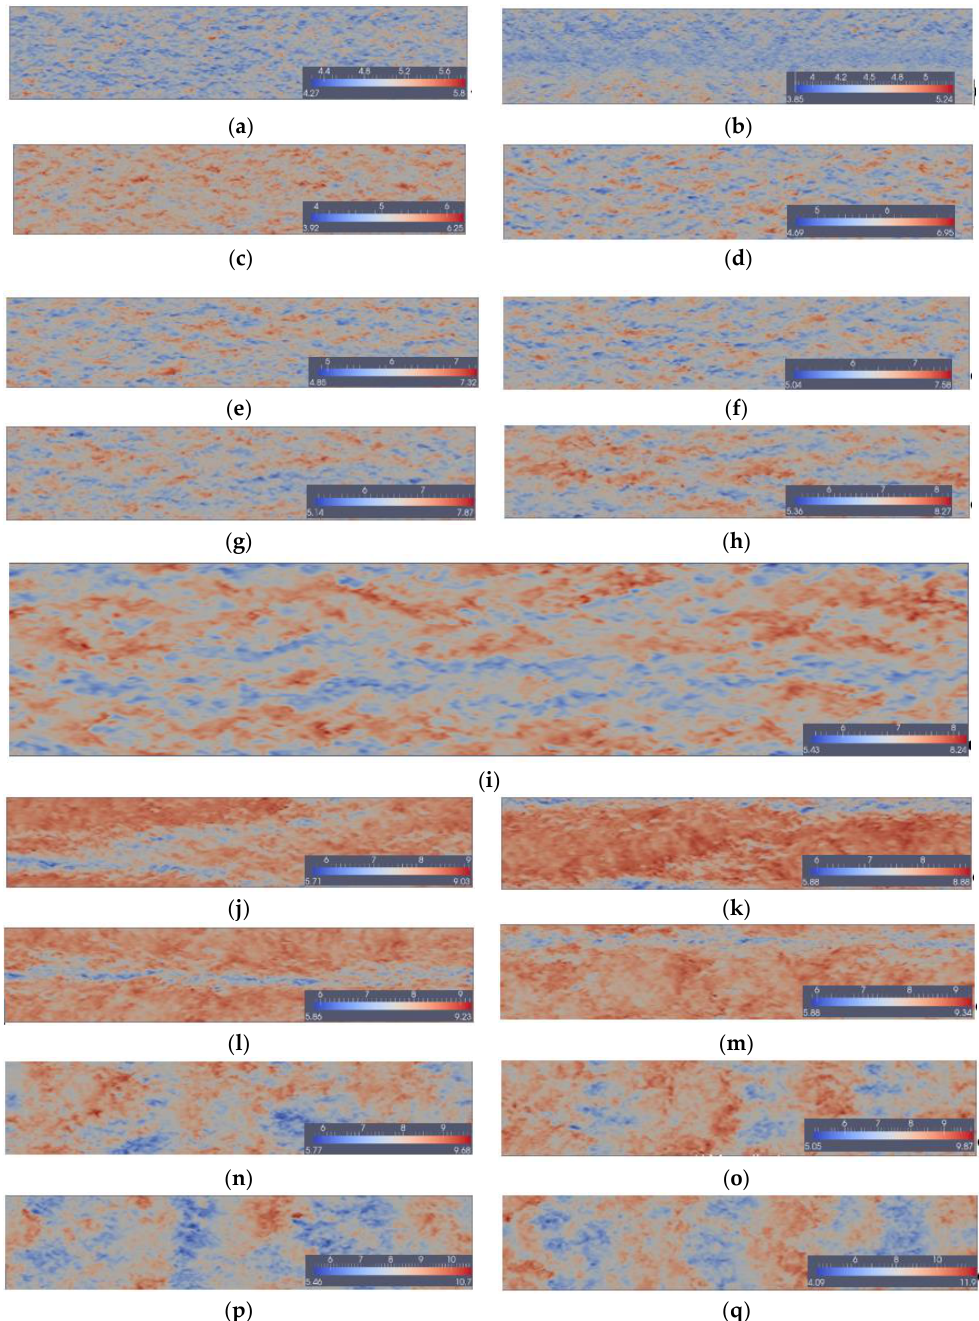
Figure 3. Streamwise velocity in the xy plane (whole domain) at a height of 0.2 for each case. ( a ) to ( q ) represent cases 1 to 17, respectively, going from very stable, to neutral and, finally, very unstable conditions.